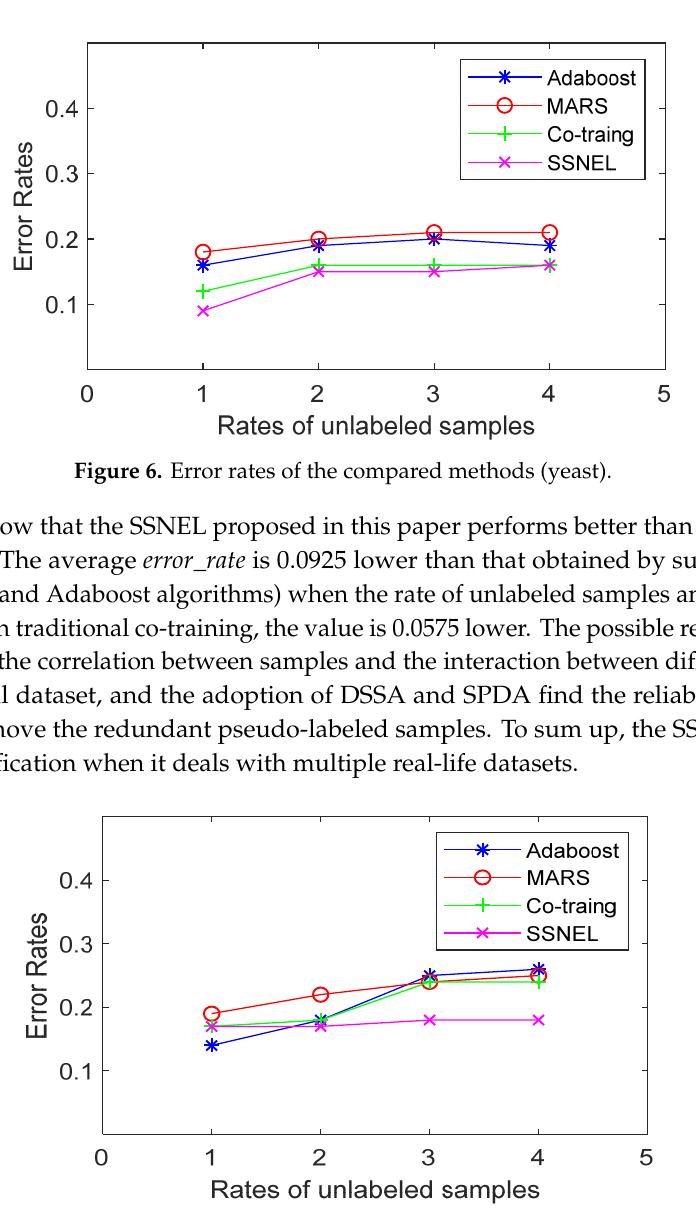
Figure 7. Error rates of the compared methods (German). Table 2. Adjustment of the parameters.